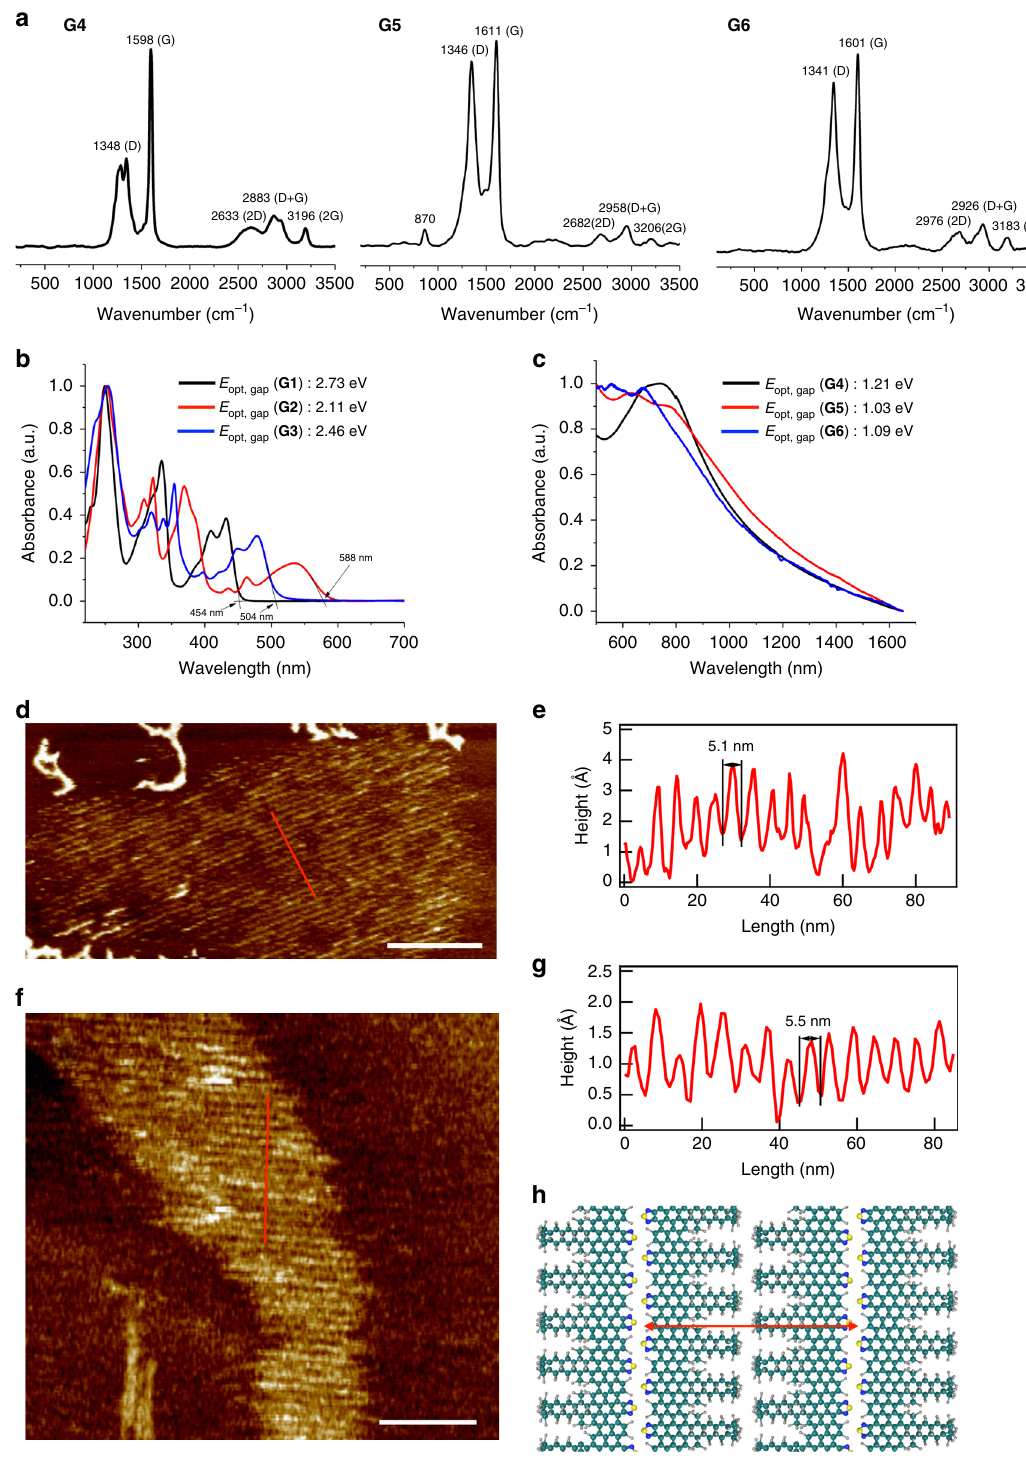
Fig. 4 Characterization of nanographenes and GNRs. a Raman spectra of G4 – G6 . b UV – vis spectra of G1 – G3 in THF solution. c UV – vis-NIR spectra of G4 – G6 in THF suspension. d AFM image of G5 on HOPG, scale bar: 70 nm. e A cross-sectional pro fi le of the image (along the red line in d ). f AFM image of G6 on HOPG, scale bar: 50 nm. g A cross-sectional pro fi le of the image (along the red line in f ). h Molecular model of G5 . Green, carbon; blue, nitrogen; yellow, sulfur; gray, hydrogen. E opt, gap : optical band-gap estimated values from M n s of the corresponding polymer precursors (22 nm for G5 and 27 nm for G6 , respectively). These values also match with the lengths estimated from the STM images (~26 nm for G4 , 26 – 38 nm G5 , 20 – 47 nm for G6 , respectively, Supplementary Fig. 18).